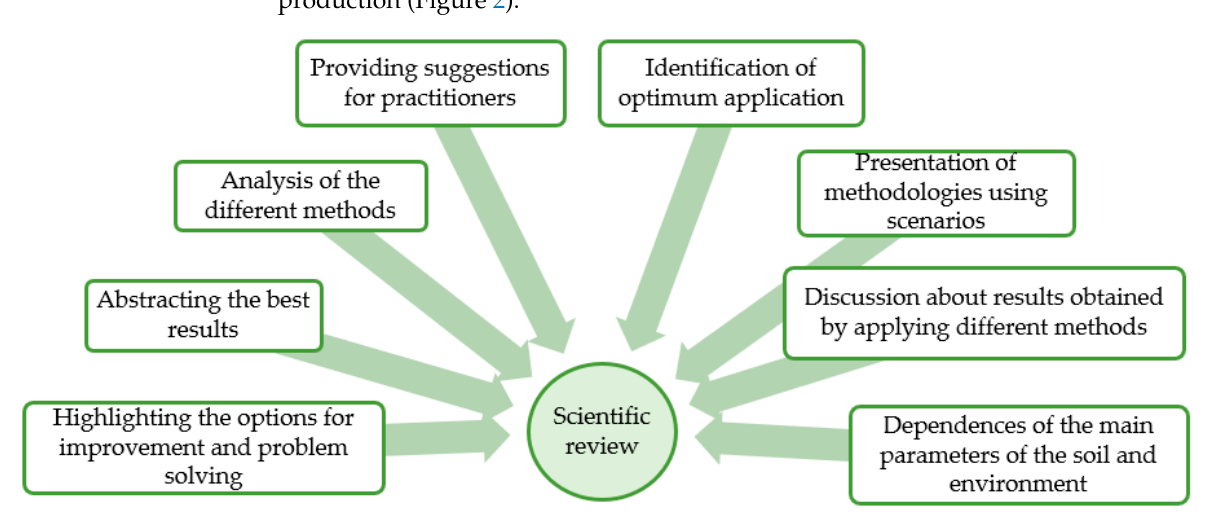
Figure 2. The components of the scientific information selection process of the review. These parts formed our review structure.